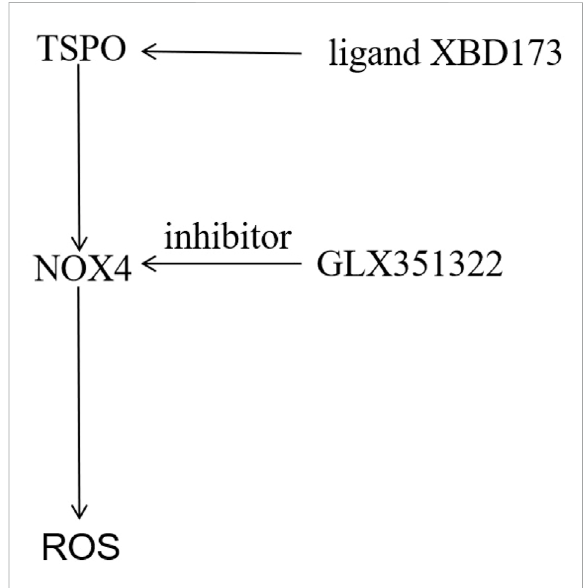
FIGURE 6 Mechanistic model of the malignant phenotype mechanism of GBM mediated by TSPO. The TSPO was the upstream target of NOX4-derived MitoROS, which was necessary for NOX4-derived MitoROS-induced angiogenesis in